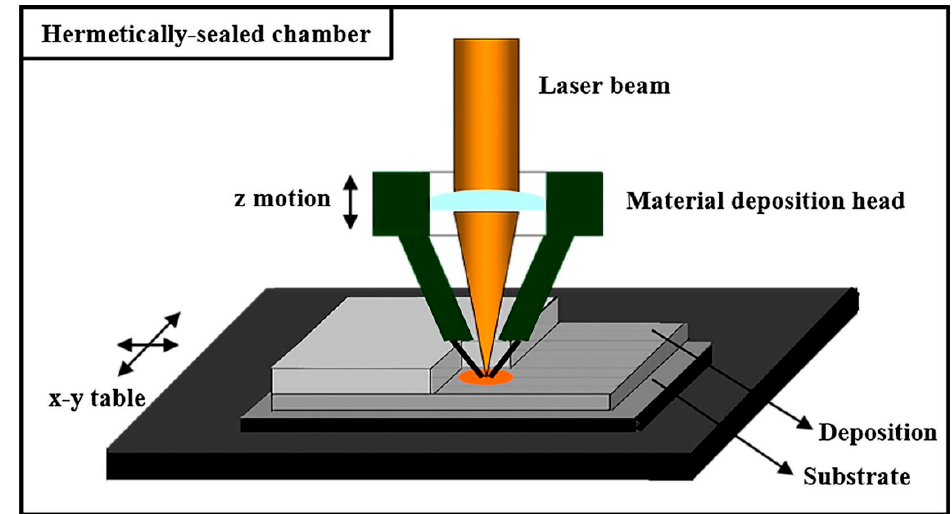
Figure 3. Typical Schematic representation of laser engineered net shaping (LENS) [26].